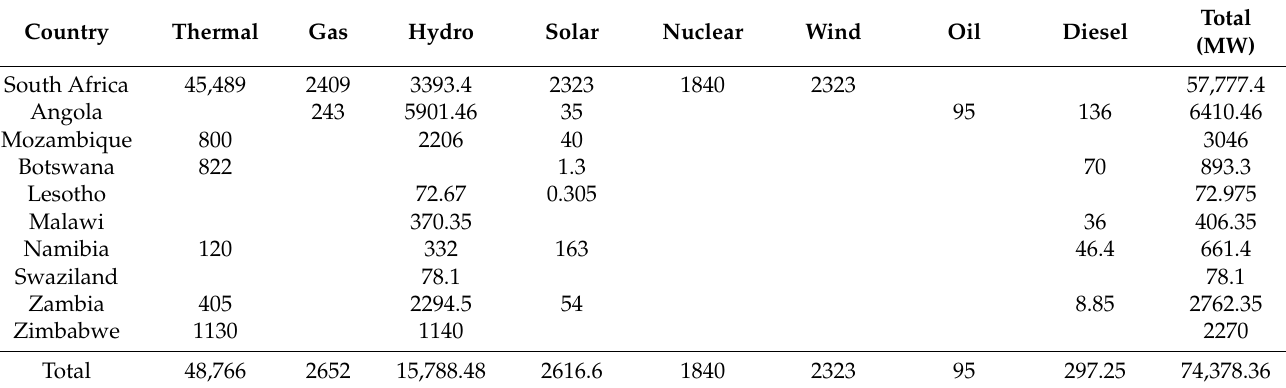
Table 2. SAPP countries and their installed capacities in